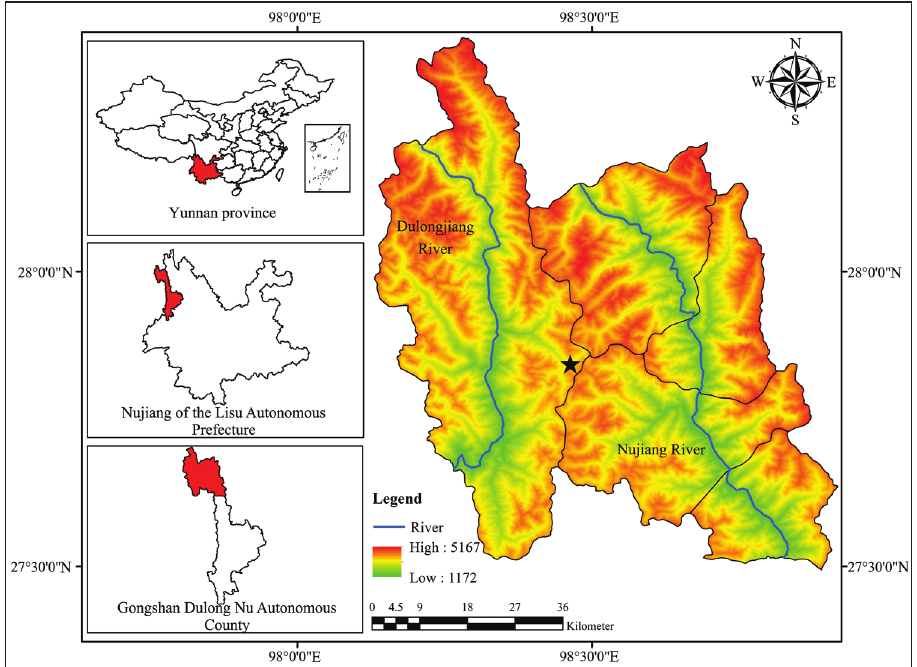
Figure 1. Distribution of Utricularia lihengiae .